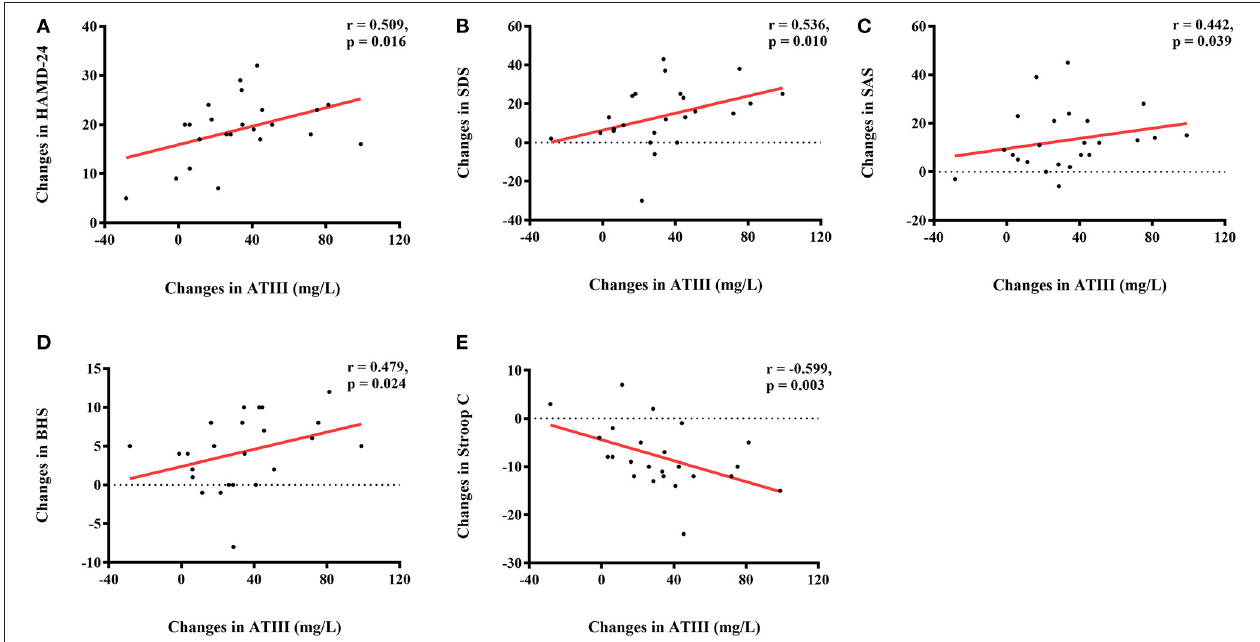
FIGURE 2 | Correlations of altered ATIII (mg/L) and changes in neuropsychological assessments in the individualized group. (A) Positive correlation between change in ATIII level (mg/L) and change in HAMD-24; (B) Positive correlation between change in ATIII level (mg/L) and change in SDS; (C) Positive correlation between change in ATIII level (mg/L) and change in SAS; (D) Positive correlation between change in ATIII level (mg/L) and change in BHS; (E) Negative correlation between change in ATIII level (mg/L) and change in Stroop C. ATIII, antithrombin III; HAMD-24, 24-item Hamilton Depression Rating Scale; SDS, Self-Rating Depression Scale; SAS, Self-Rating Anxiety Scale; BHS, Beck Hopelessness